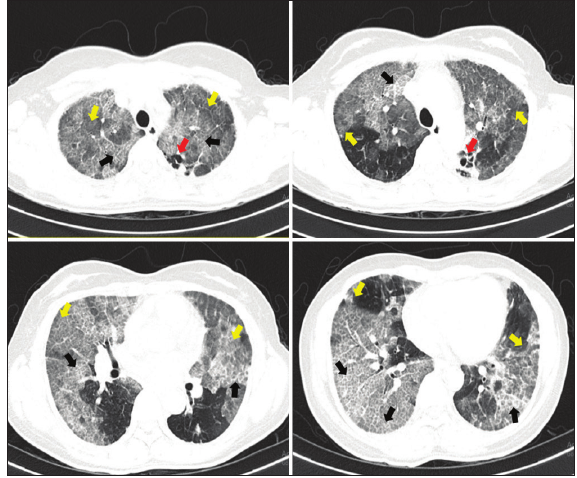
FIGURE 2. The chest high-resolution computed tomography (January 2020) showed ground-glass opacity (yellow arrows) with reticulation changes (black arrows), a combination known as crazy paving pattern, and cavities on the upper lobe of the left lung (red arrow).